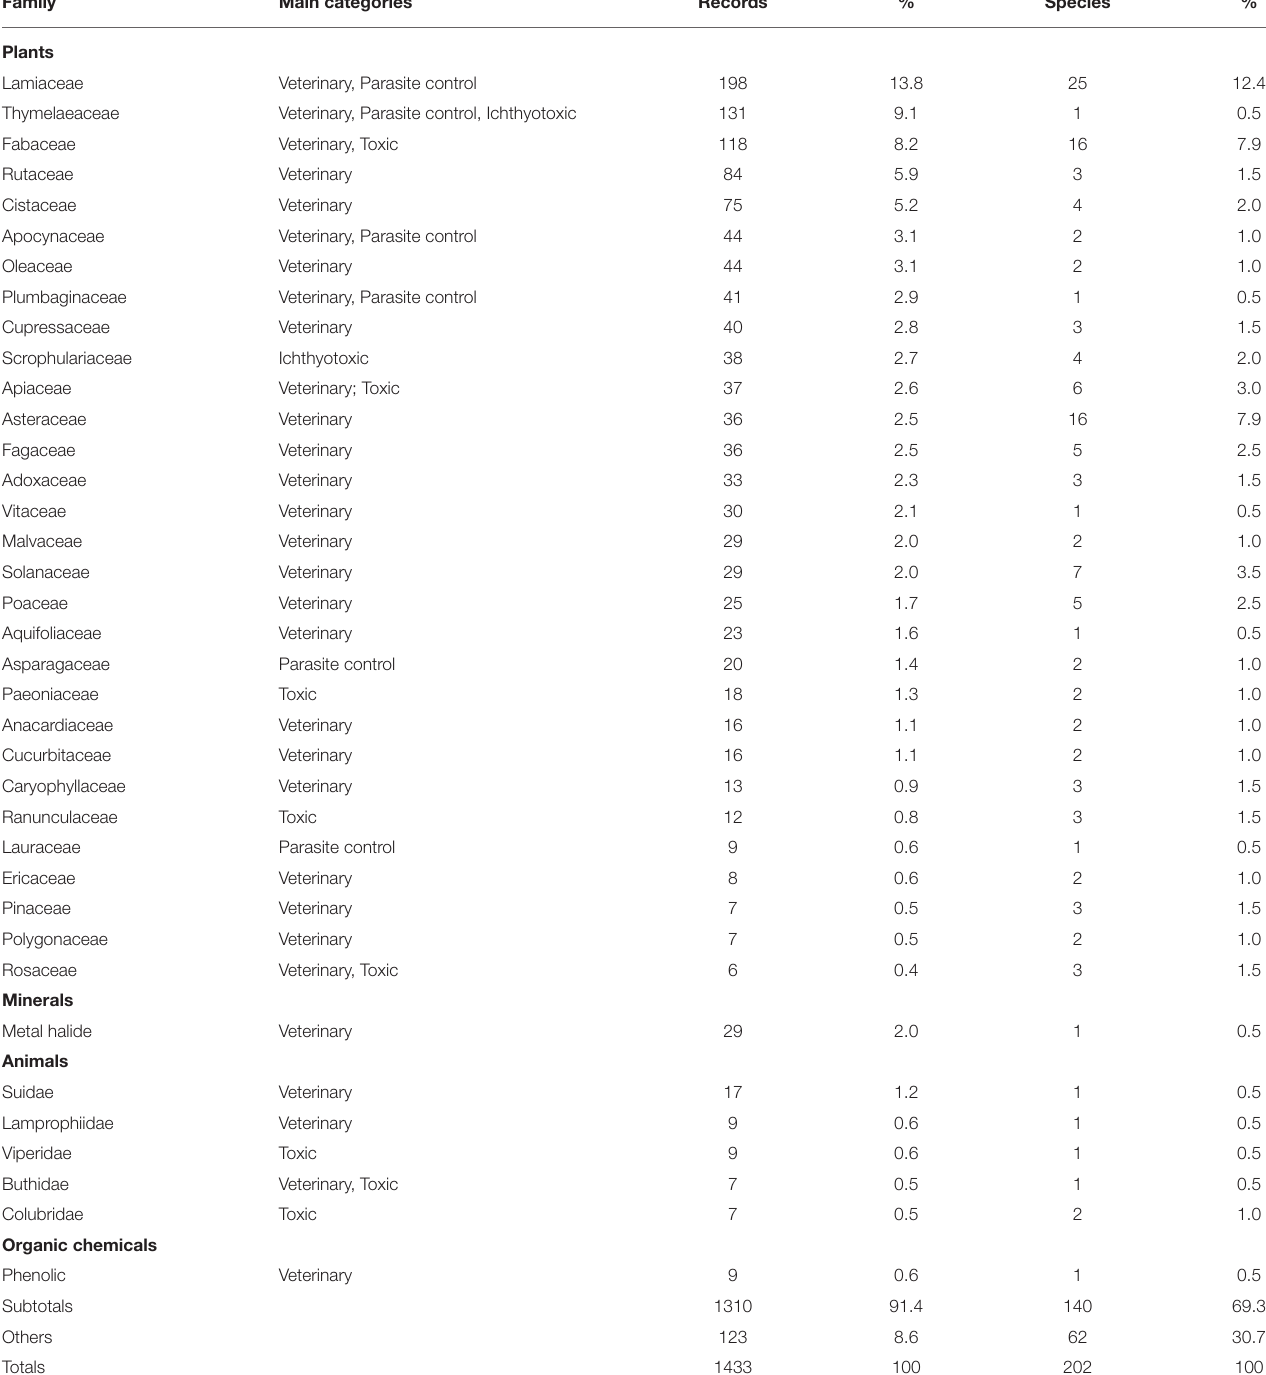
TABLE 2 | Plant (and other) families more often present in the